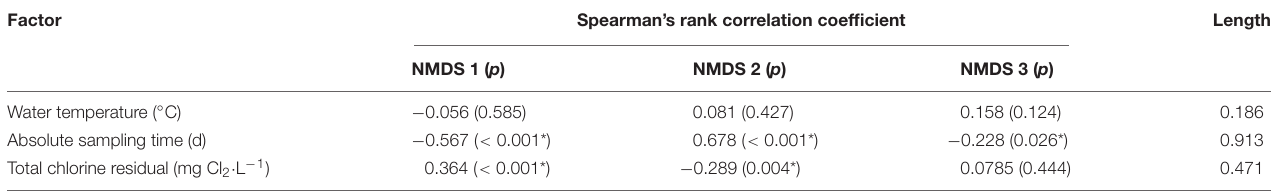
TABLE 2 | Shifting of bacterial communities in the 3D NMDS space by water temperature, absolute sampling time, and total chlorine residual